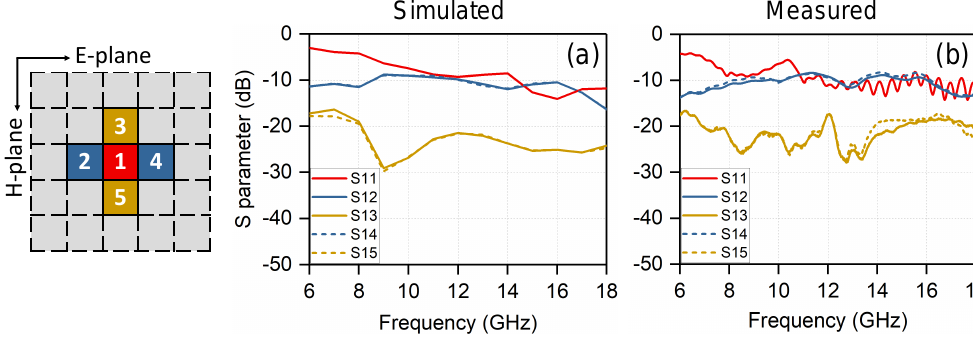
Figure 13. Simulated and measured S-parameter for the selected ports of the prototype